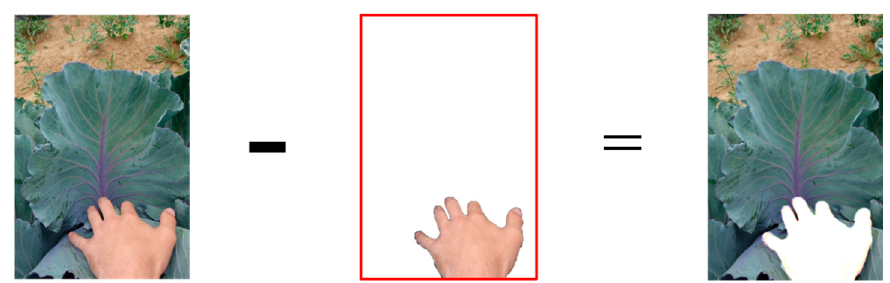
Figure 4 . Removing foreground objects using background subtraction. Figure 4. Removing foreground objects using background